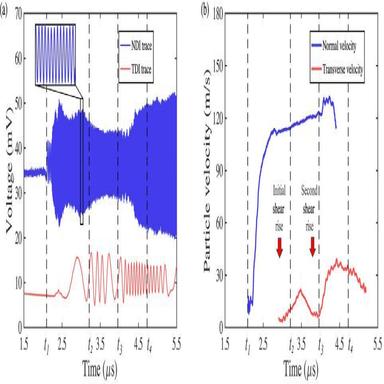
Typical experimental results (shot10 shown): (a) laser interferometer fringes; the blue line is the NDI signal and the red line is the TDI signal. The resolution (one total phase change) for NDI is 266 nm per fringe and 2.5 μm per fringe for TDI; (b) normal and transverse particle velocity curves at the back surface of target plate assembly.